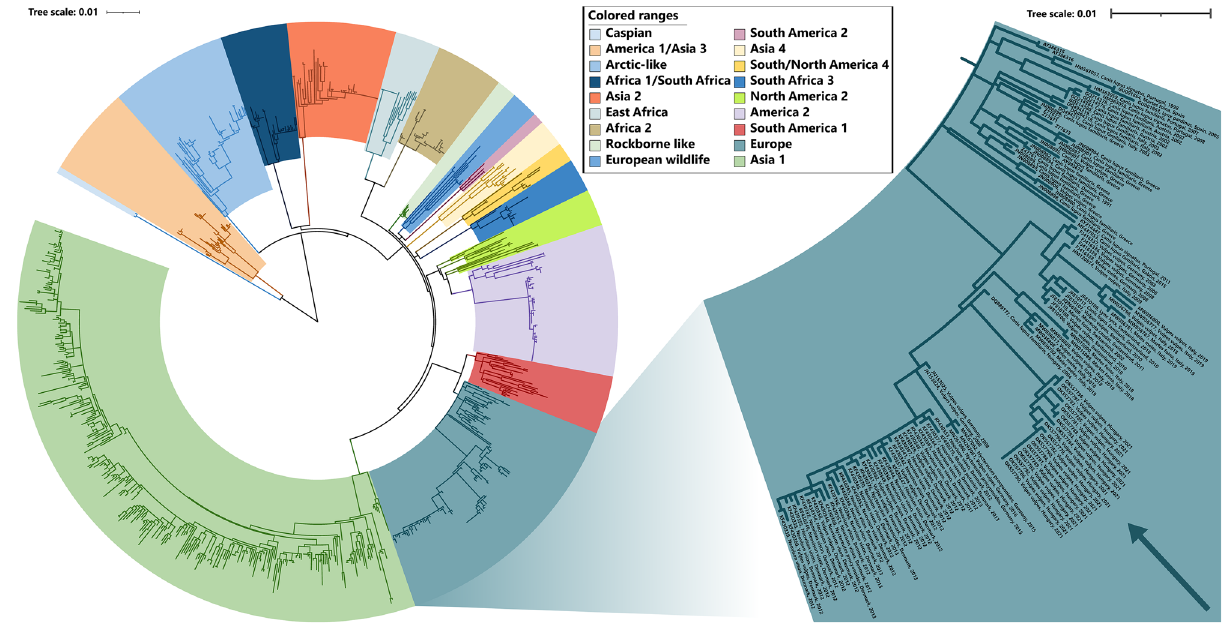
Figure 2. Maximum Likelihood phylogenetic tree based on 846 complete hemagglutinin (H) nucleotide sequences. Phocine distemper virus (PDV) (GenBank accession number: KY629928) was used as an outgroup to root the phylogenetic tree. The Europe lineage of interest is highlighted in light